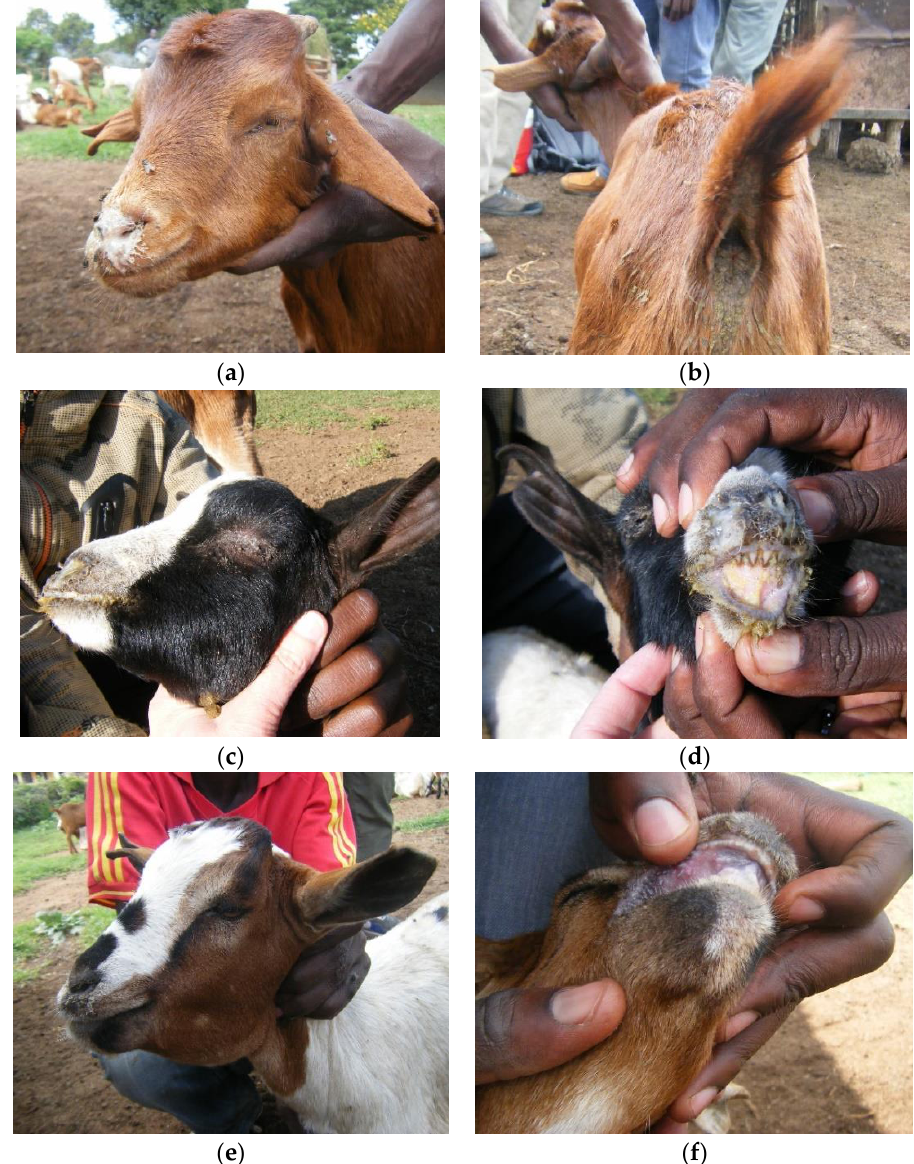
Figure 5. PPR cases in Flock 3 (confirmed PPRV infected) in Olorien-Magaiduru showing a range of clinical signs. ( a ) A 2-year-old goat (G10) with pyrexia, ocular discharge, mucoid nasal discharge blocking nostrils, and ( b ) diarrhoea and straining—peste des petits ruminants virus (PPRV) rapid diagnostic test (RDT) and PPRV real-time reverse transcription polymerase chain reaction (RT-qPCR) positive; ( c ) 3-month-old goat with ocular discharge (eyelids stuck together), nasal discharge, and ( d )